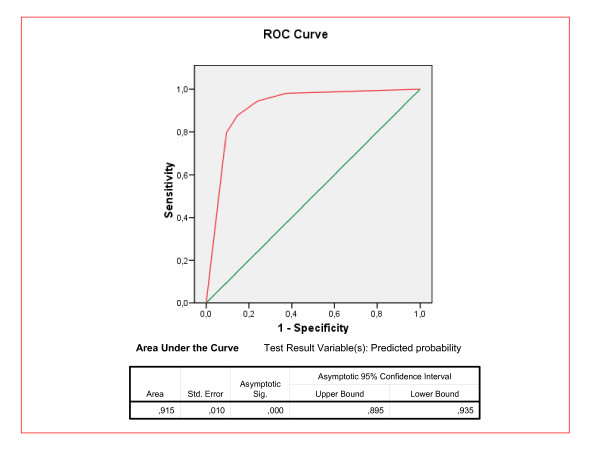
ROC curve for the D'Agostino scale versus SCORE 5%. The test result variable(s): Predicted probability has at least one tie between the positive actual state group and the negative actual state group.